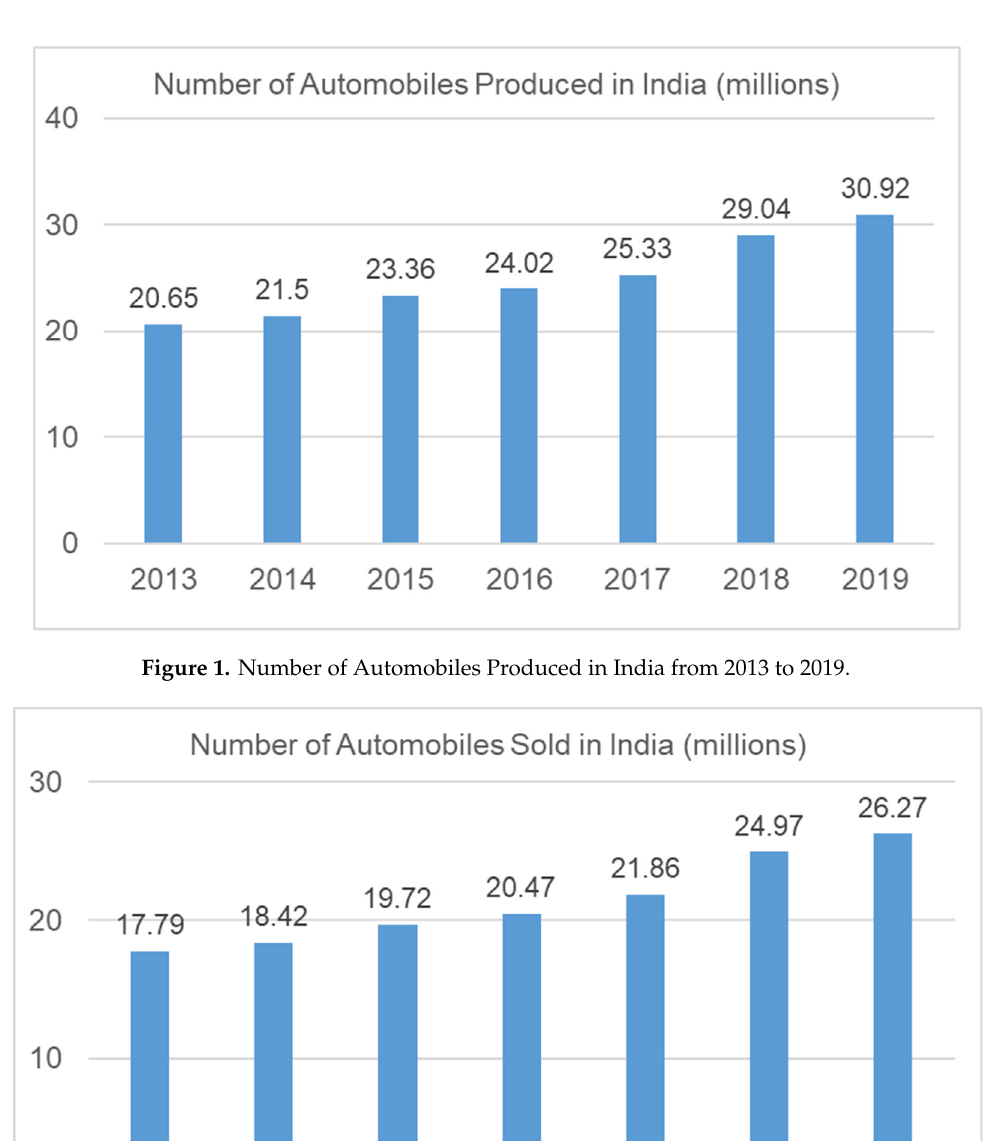
Figure 3. Segment Wise Market Share of Vehicles in 2019. There are around 54 companies in the country manufacturing, assembling and producing all the segments of the vehicles. The main automotive manufacturing dominated regions include Delhi, Kolkata, Maharashtra, Chennai and Karnataka. Some of the factors listed below prove that the Government of India has a clear vision to make India an automotive manufacturing hub, including the following points: 